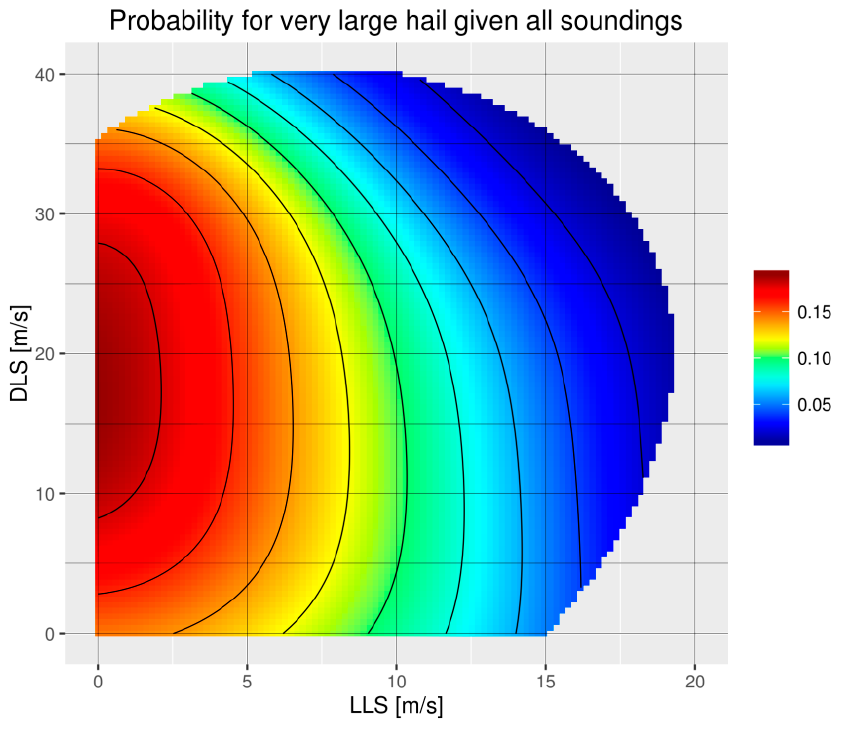
Figure 10. As in Figure 9, except for the very large hail.